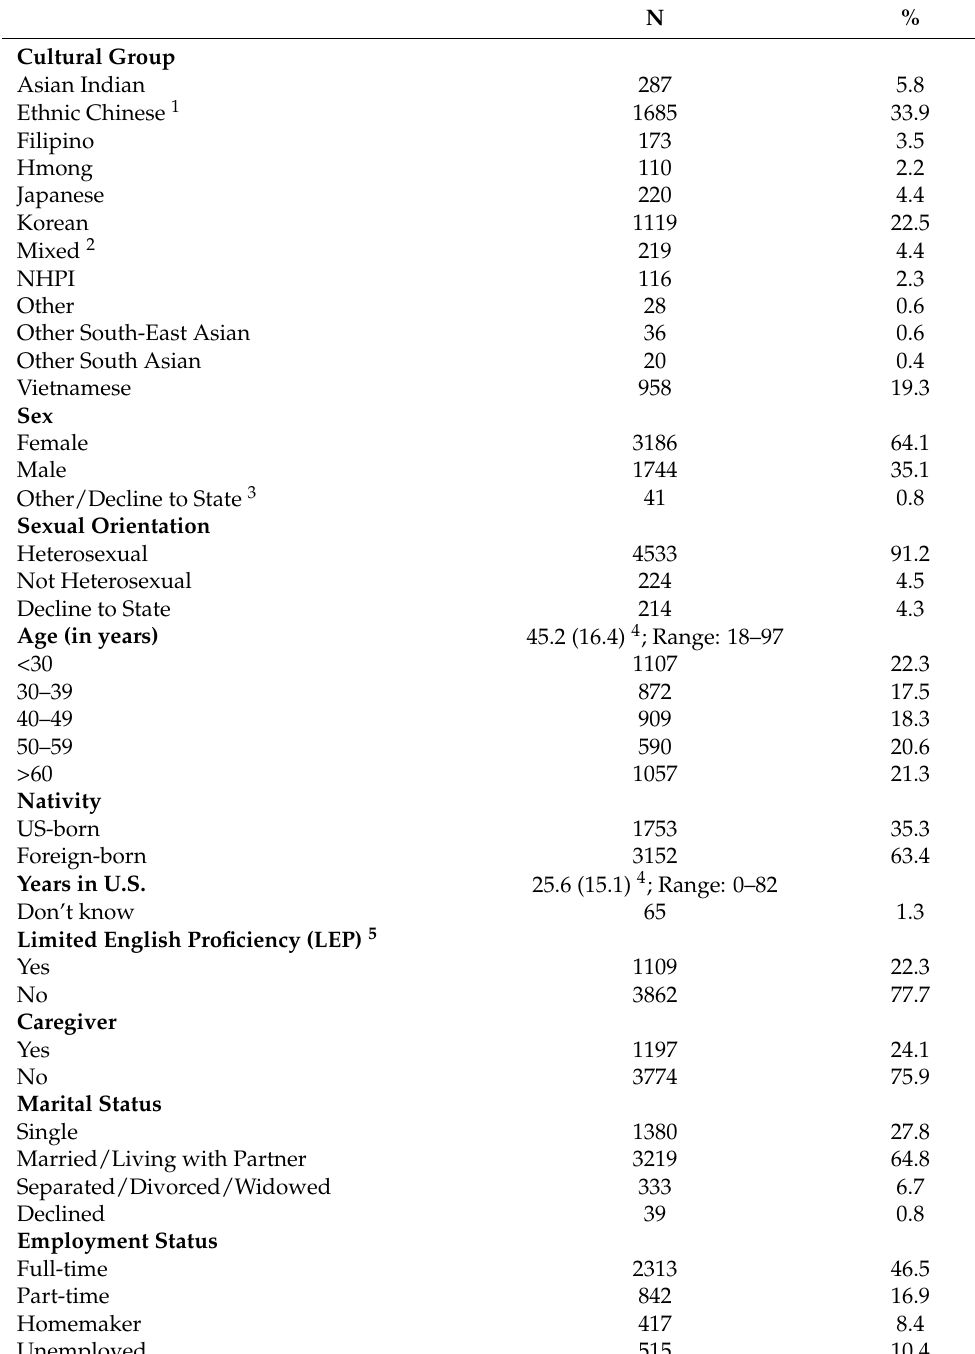
Table 1. COMPASS study sample characteristics (N =